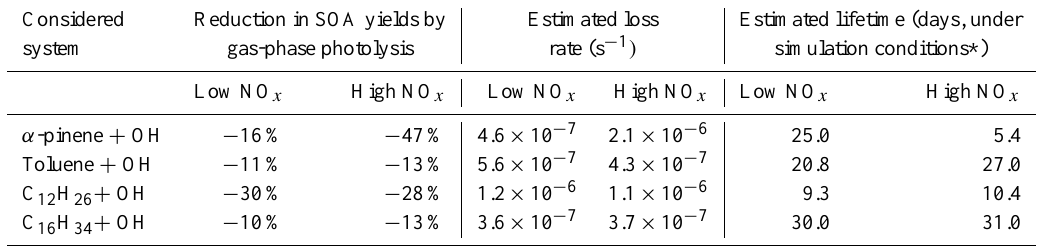
Table 3. Predicted reduction in SOA yields due to gas-phase photolysis, and corresponding first-order loss rates and lifetimes. The results are from the GECKO-A BASE case simulation, and yields values are taken at the maximum of the SOA formation from each precursor. The loss rate coefficients were estimated by numerically fitting the first-order decay of SOA due to photolysis occurring over 1 week of